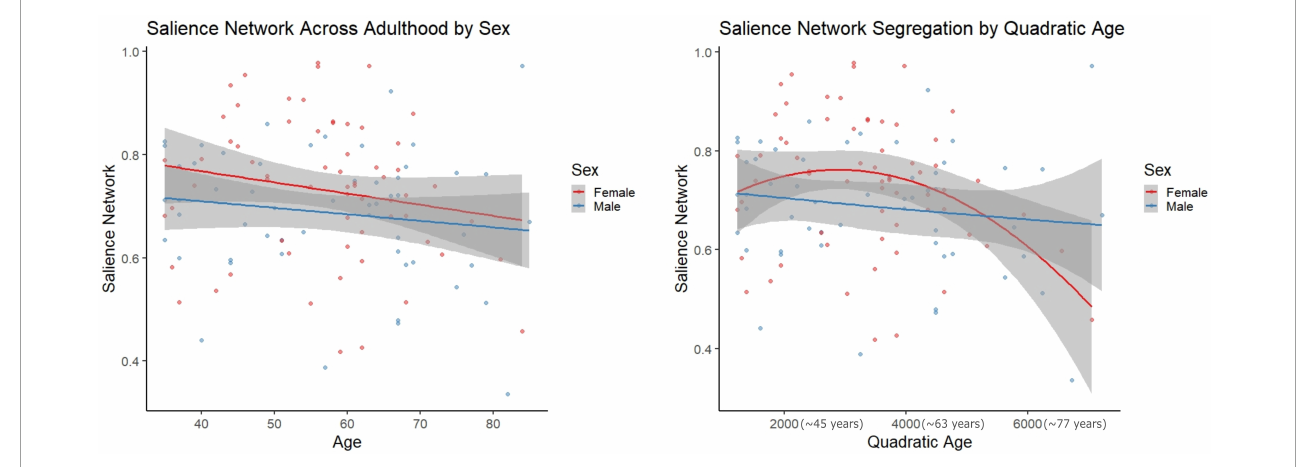
FIGURE4 Scatter plots demonstrate the linear (left) and quadratic (right) relationship between salience network connectivity and age. Parentheses next to quadratic values (right) indicate the approximate square root of the quadratic value for interpretative purposes. The gray superimposed on each colored line depicts the 95% confidence interval in each sex. The quadratic model demonstrated significantly better fit than the linear model for salience network segregation across adulthood (AIC difference =